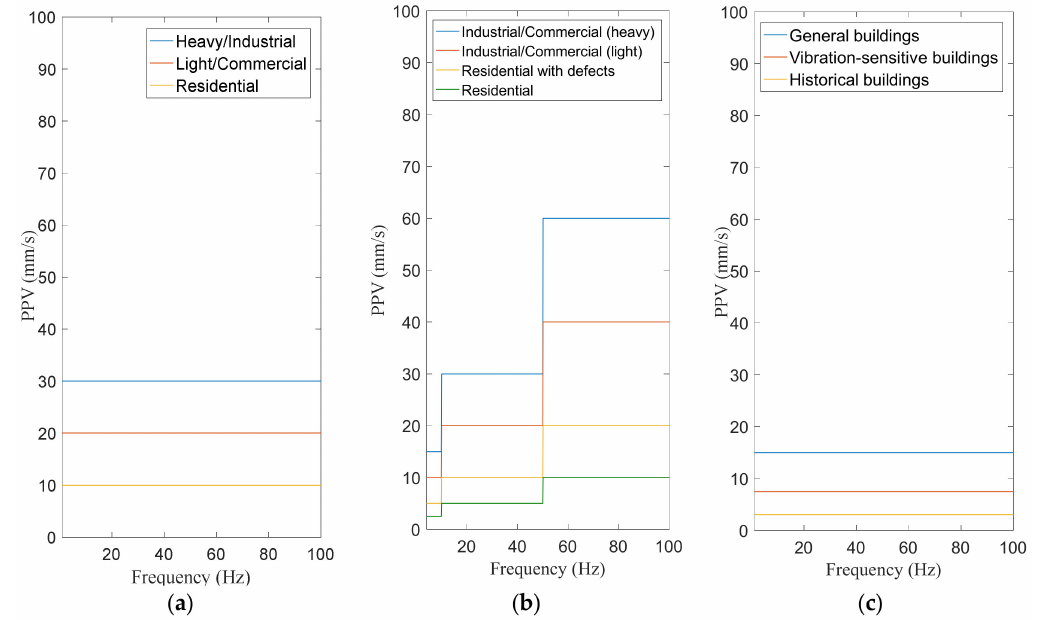
Figure 1. Maximum acceptable peak particle velocity (PPV) limits defined in ( a ) Eurocode 3 [10], ( b )BS5228[9], and( c